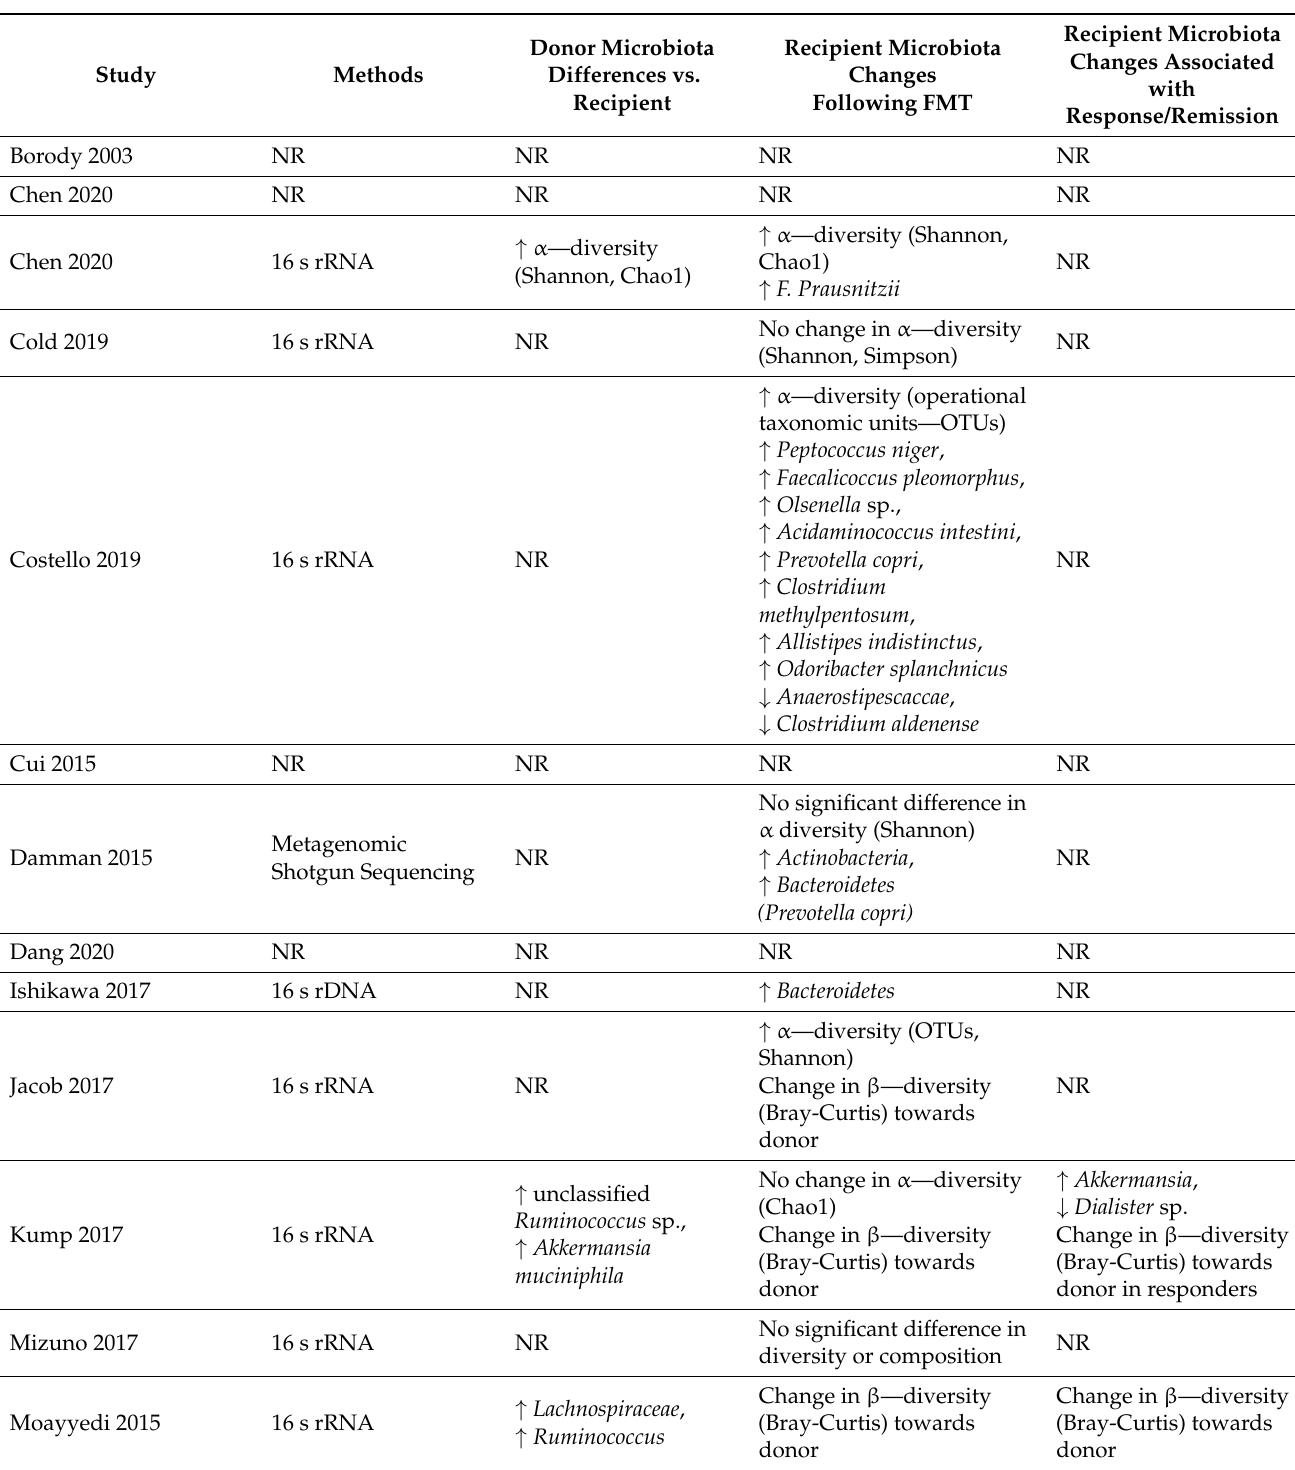
Table 4. Effect of fecal microbial transplant therapy on microbiota